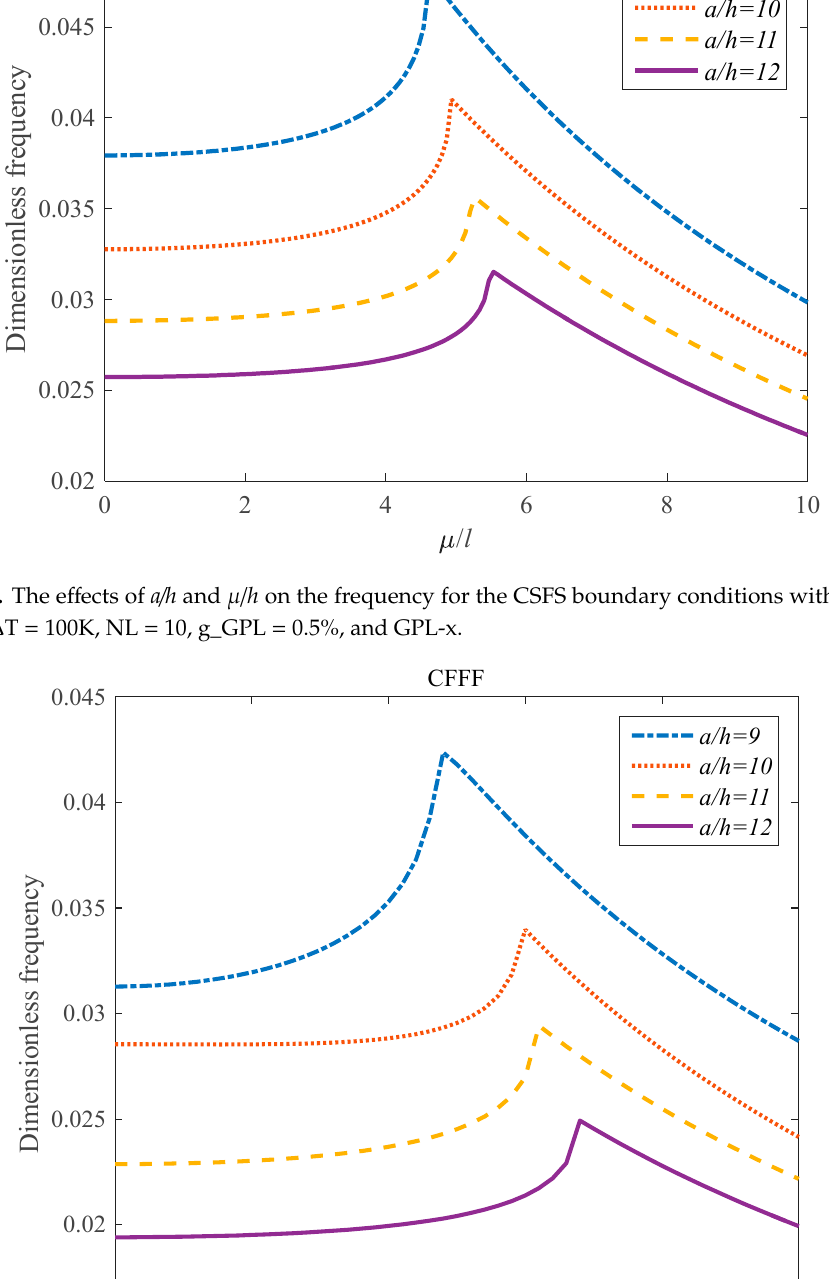
Figure 6. The influences of a / h and µ / h on the frequency for the CFFF boundary conditions with a / b = 5, l = h / 5, ∆ T = 100K, NL = 10, g_GPL = 0.5%, and GPL ‐ x.